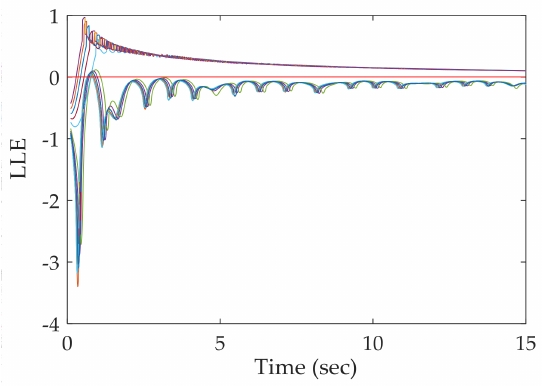
Figure 8. LLE–time curves with different fault clearing times for the mentioned fault scenario of the IEEE-39 bus test